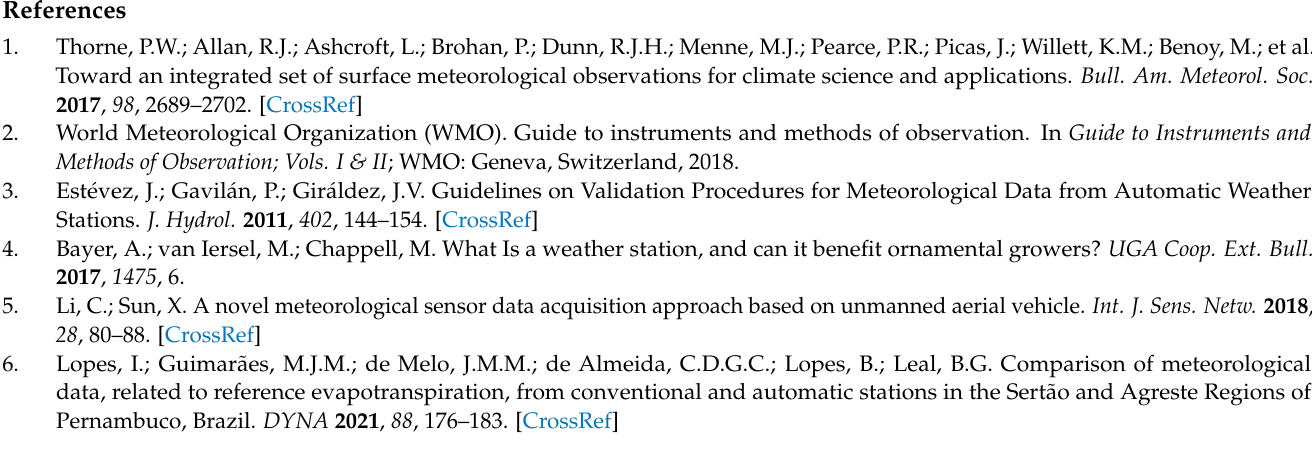
Figure A5. hPBL calculation using three methods: potential temperature gradient, relative humidity gradient, and mixing ratio gradient, for the 10 WRF vertical profiles, 5 in the graphs above, and 5 in the graphs below.